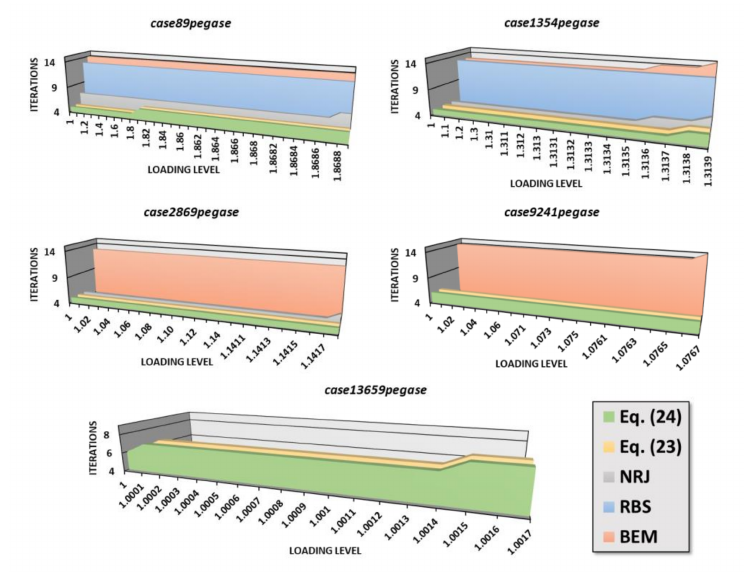
Figure 2. Total number of iterations for high loading